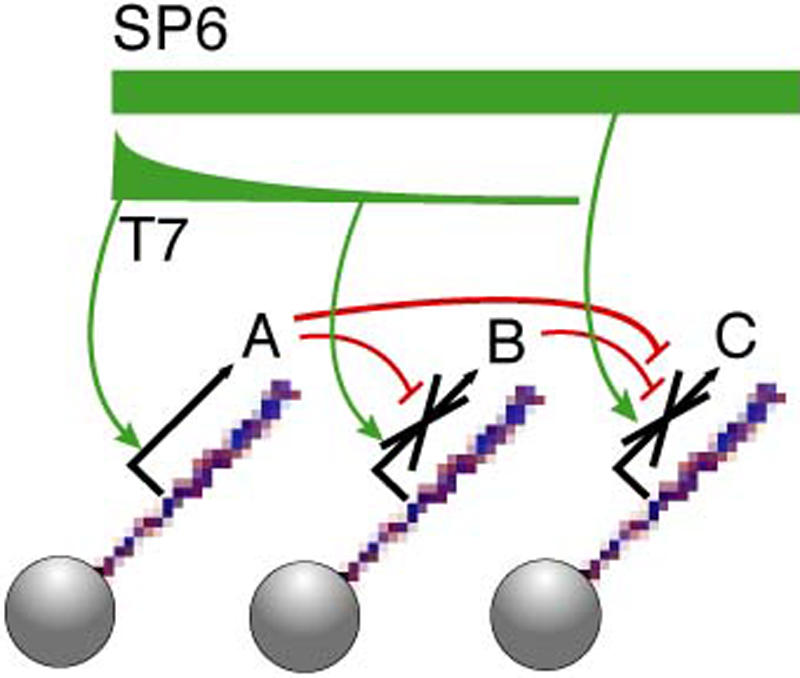
An artificial network to study patterning in development